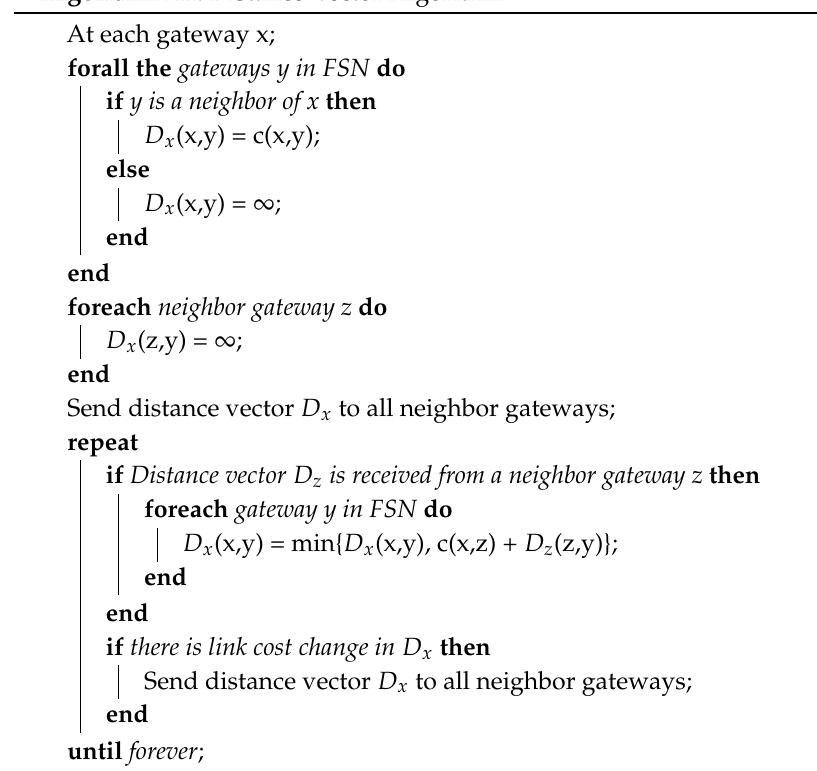
Algorithm A1: Distance-Vector Algorithm